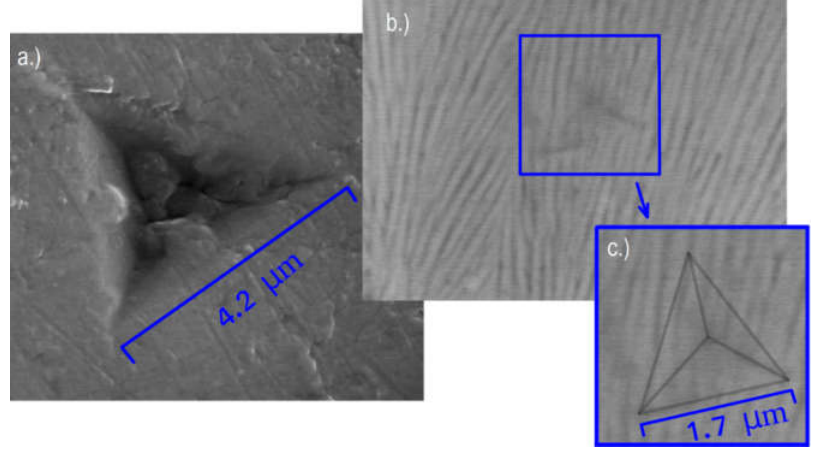
Figure 11. Indentation patterns on ( a ) the substrate and ( b , c ) at the middle of the anodized layer, obtained by using the combination of SEM and nanoindentation.